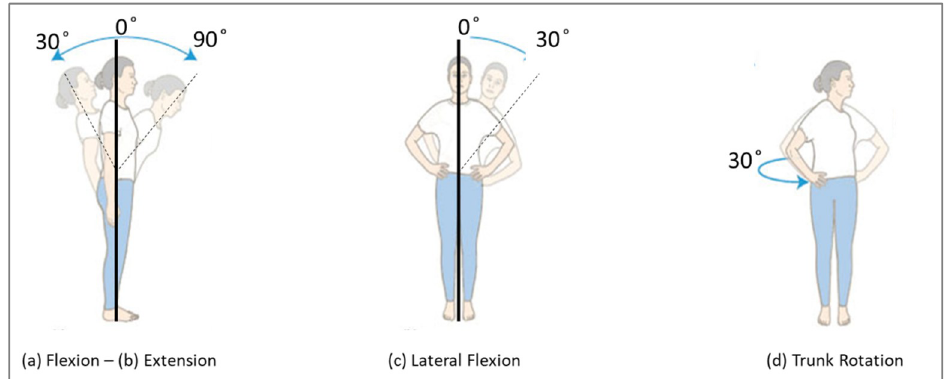
Figure 5. The four therapeutic exercises that will be performed to play the game. Table 2. Mapping the game challenges to the player movements. Game challenge Rabbit movement Player movement